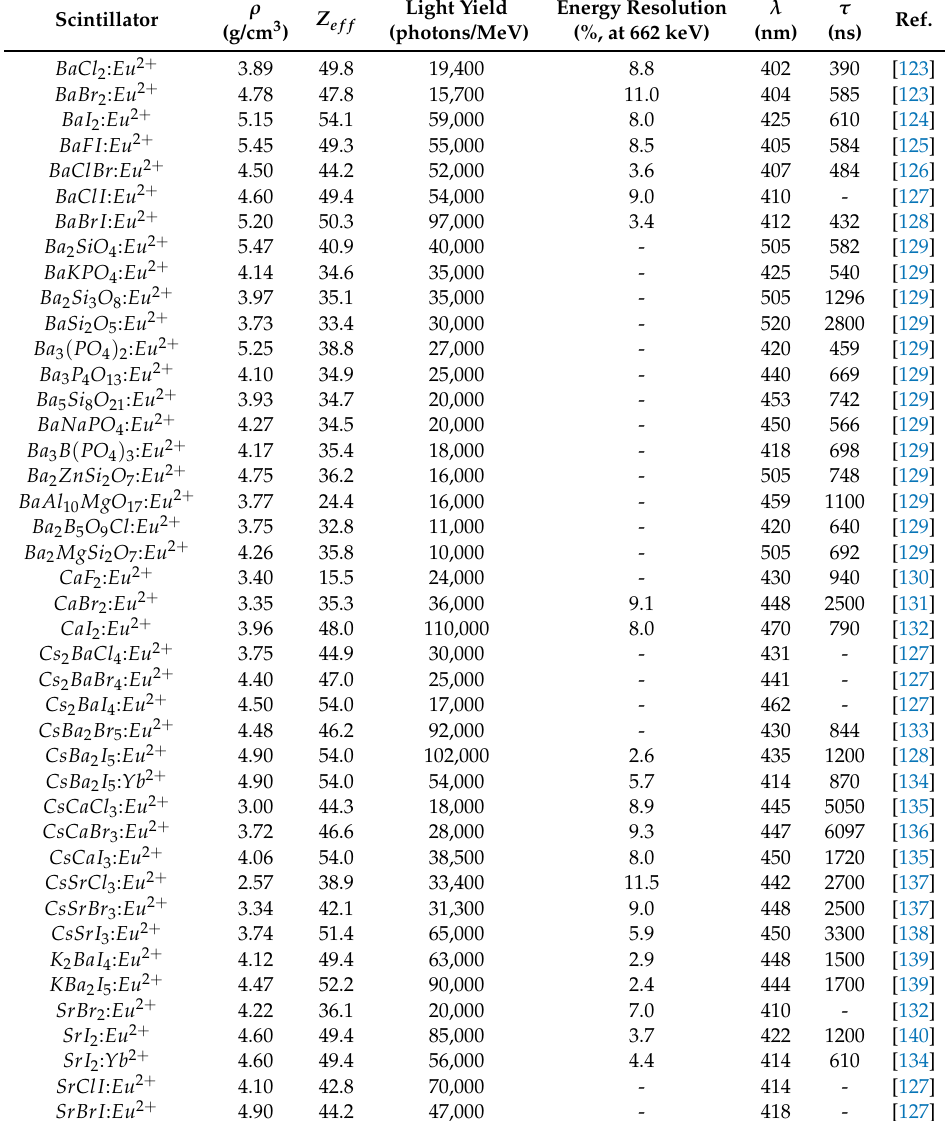
Table 4. Overview of some Eu 2 + and Yb 2 + doped scintillators. The same convention as in Table 1 is